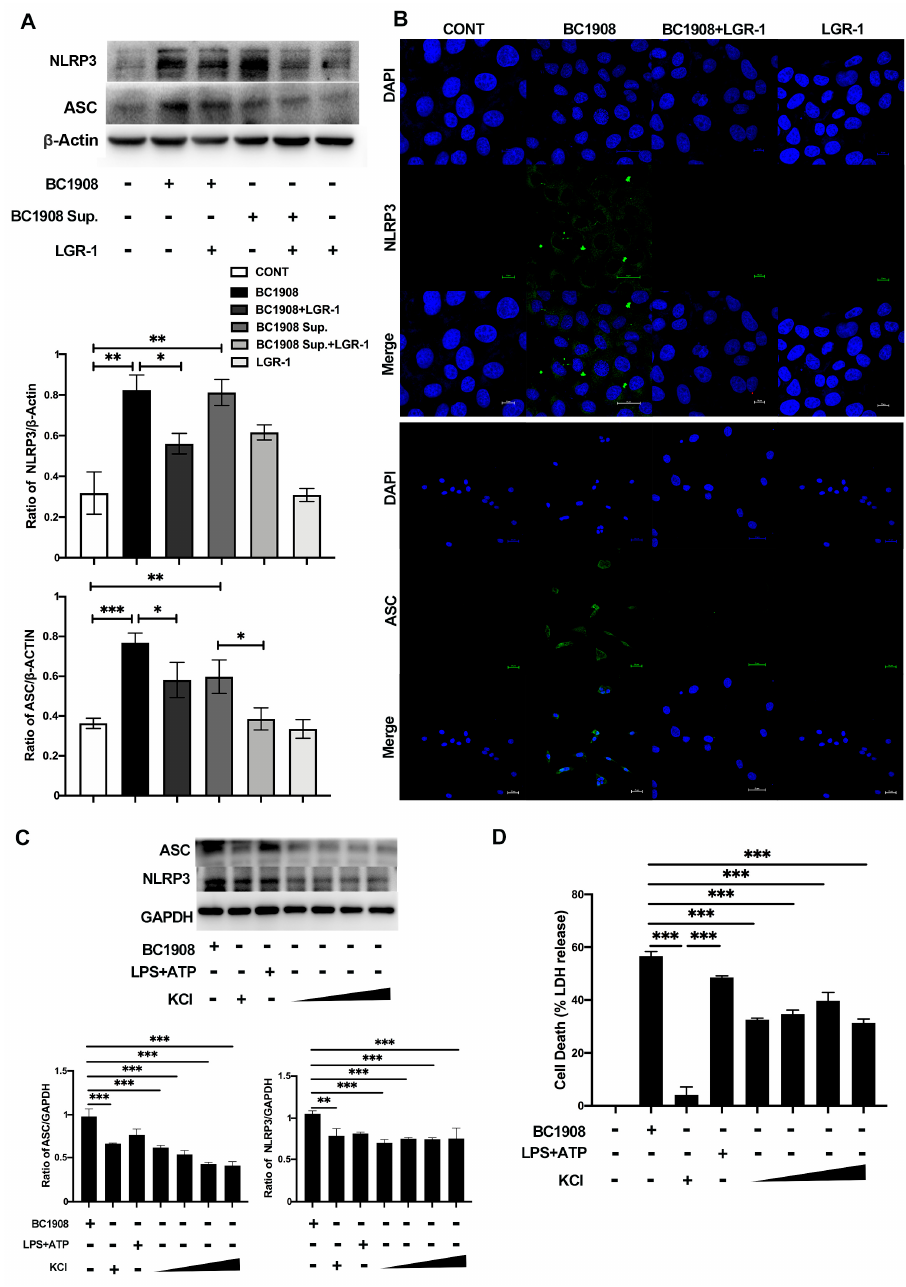
Figure 3. LGR-1 inhibits the activation of cellular inflammatory proteins (NLRP3 and ASC) caused by BC1908 and the supernatant of BC1908. ( A ) The WB results show that BC1908 activates NLRP3 and ASC, and LGR-1 relieves this. ( B ) The results of immunofluorescence show that LGR-1 down- regulated NLRP3 and ASC of cells, caused by BC1908. Scale bar is 25 µ m. ( C ) Inhibition of different concentrations of potassium ions on NLRP3 and ASC. ( D ) The exploration of the effect of adding different concentrations of K + to cell LDH. (* p < 0.05, ** p < 0.01, *** p <